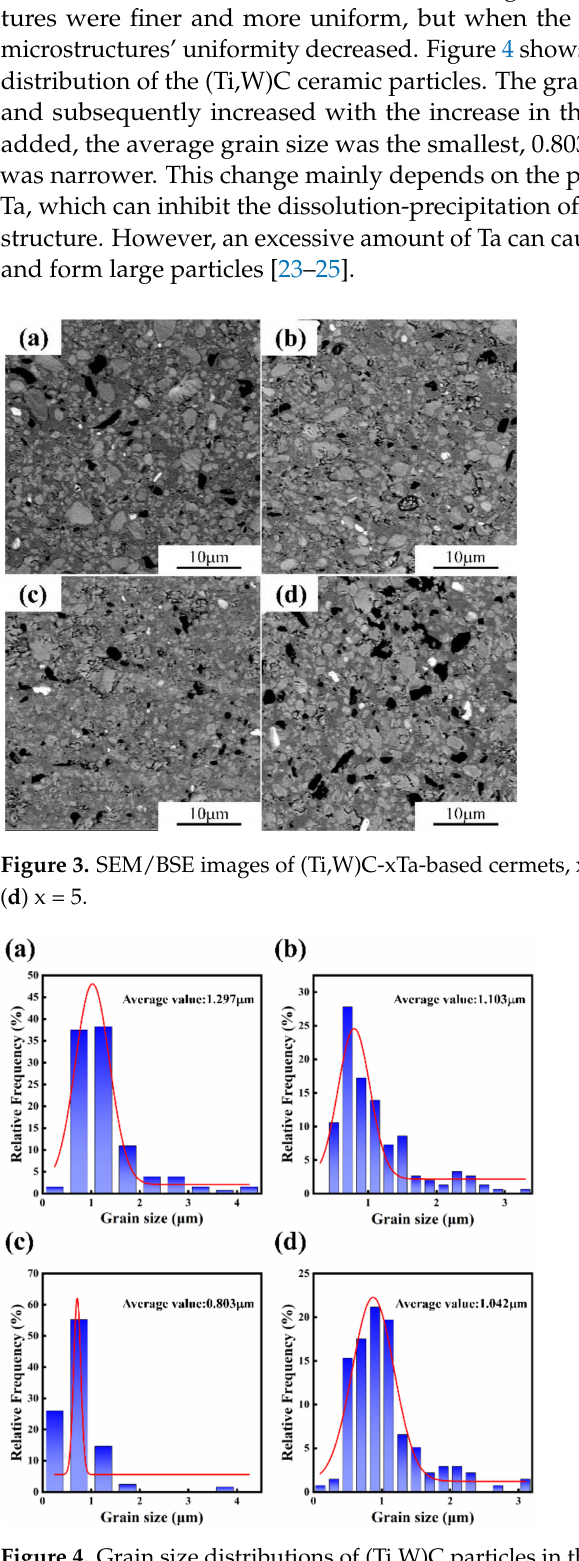
Figure 4. Grain size distributions of (Ti,W)C particles in the microstructures of (Ti,W)C-xTa-based cermets, x in wt.%: ( a ) x = 0, ( b ) x = 1, ( c ) x = 3, and ( d ) x =